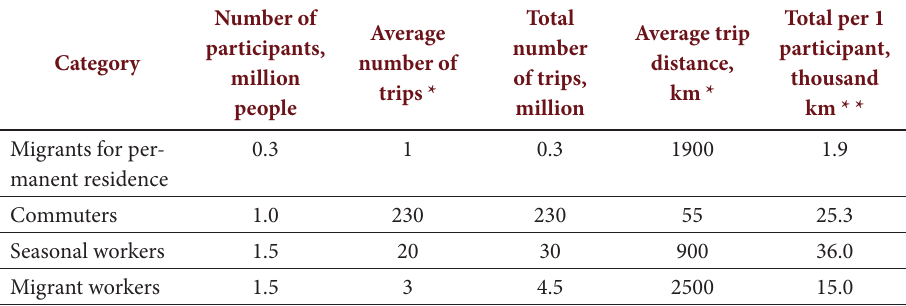
Table 3. Calculated parameters of population mobility in Moscow, 2012-2013 Number Category